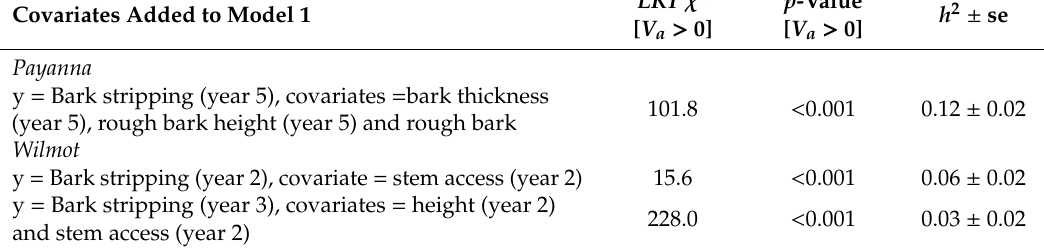
Table 9. Genetic estimates for bark stripping derived from models that accounted for covariation in tree physical traits in Payanna and Wilmot trials. No significant correlations between bark stripping and physical traits were detected in Beulah. Shown are the chi-square value ( χ 2 ) and probability for the one-tailed likelihood ratio test (LRT) that the additive variance ( V a ) in bark stripping is greater than zero and its narrow-sense heritability ( h 2 ) and its associated standard error (se) estimated with univariate spatial models. The heritability estimates calculated without fitting covariates are given in Tables